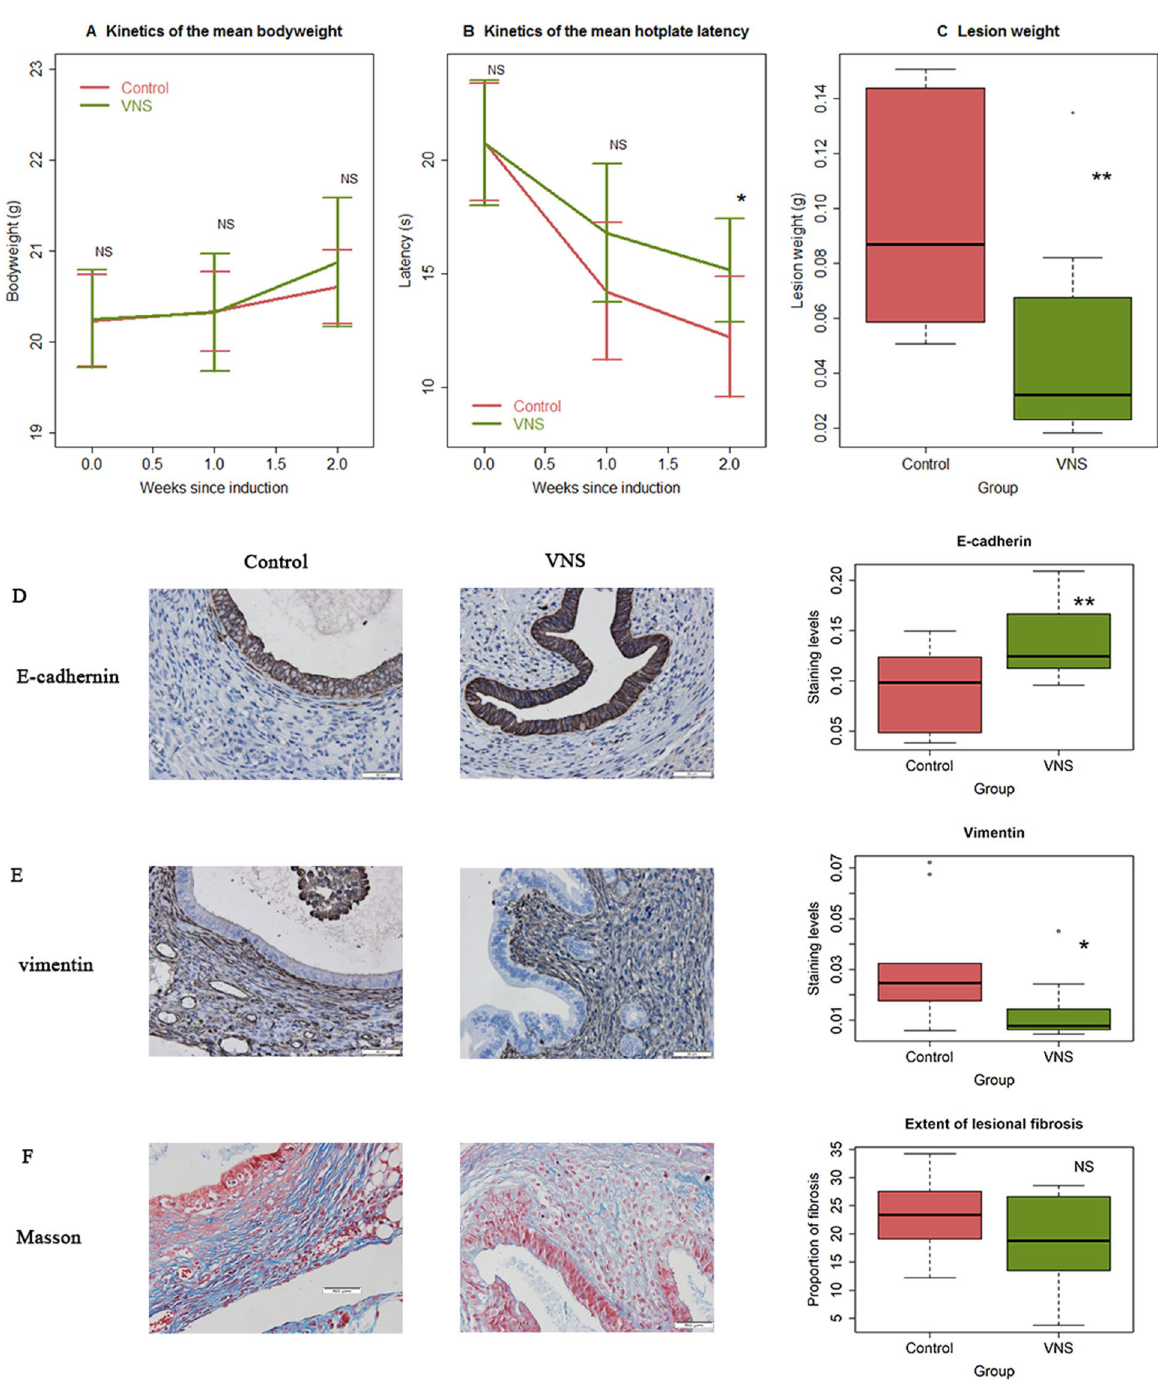
Figure 3. Vagal nerve stimulation (VNS) decelerates the development of endometriosis in mouse. ( A ) Kinetics of the mean bodyweight in control and VNS groups. No significance was found between two groups at any time point evaluated. ( B ) Kinetics of the mean hotplate latency, tested at the indicated times in the two groups. Statistically significant difference in latency between the two groups is found at the end of the experiment, 2 weeks after the induction of endometriosis. ( C ) Boxplot summarizing the lesion weight data between control and VNS mice. Representative immunostaining results for E-cadherin ( D ) and vimentin ( E ) in endometriotic lesions from control and VNS mice (left panel), along the boxplot summarizing the staining data (right panel). ( F ) Representative images of Masson trichrome staining in endometriotic lesions in control and VNS groups (left panel), along with the boxplot summarizing the staining data (right panel). n = 10 in each group. The asterisk indicates the statistical significance level, based on linear regression using group indicator: NS: p > 0.05; * p < 0.05; ** p < 0.01. The R 2 values for E-cadherin and vimentin were 0.51 and 0.27, respectively. For the exent of fibrosis, R 2 =